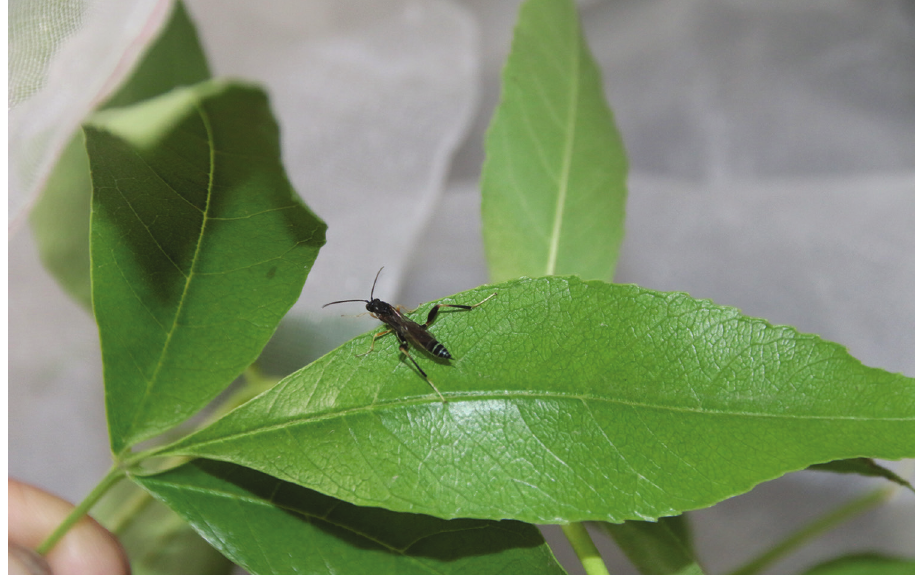
Figure 25. Bicurta hejunhuai sp. nov., female paratype on a leaf of Fraxinus pennsylvanica in Shenyang City, Liaoning province (cell phone photo by Jia-He Yan).